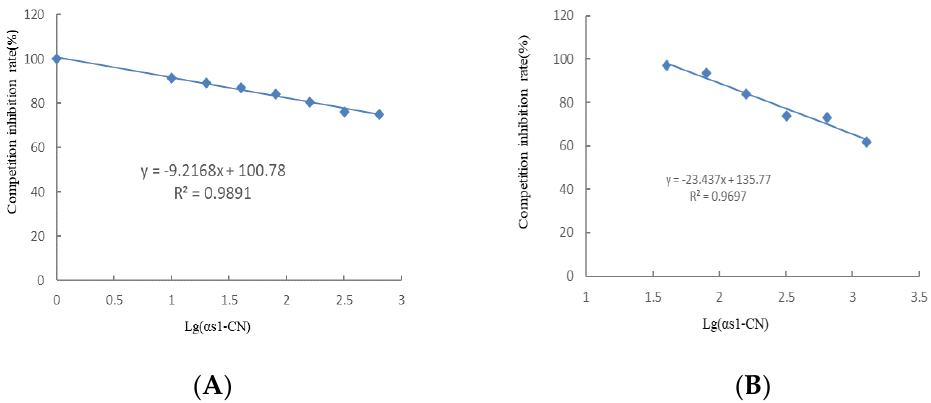
Figure 3. Indirect competitive ELISA inhibition curve of mAb against α s1 -casein epitope ( A ) and α s1 - casein protein ( B ).